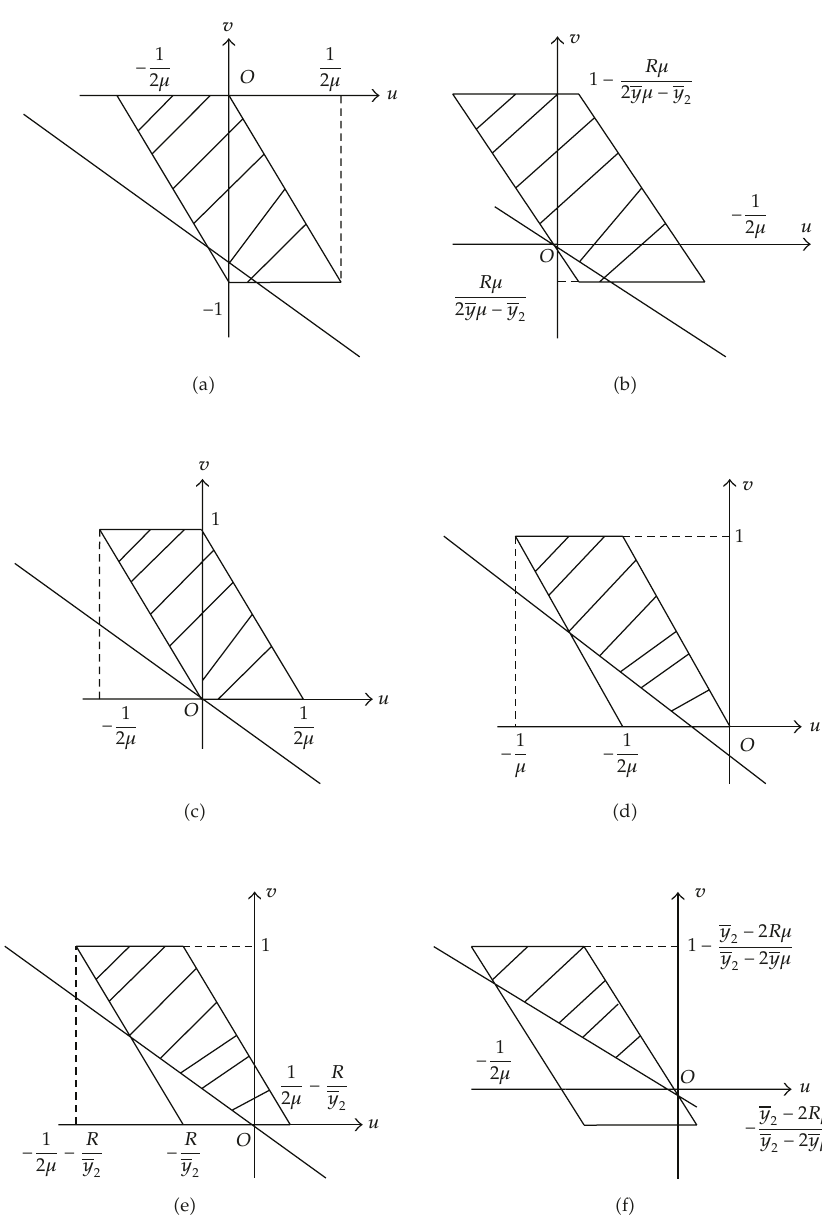
Figure 2: Feasibility areas for the coe ffi cients u and v